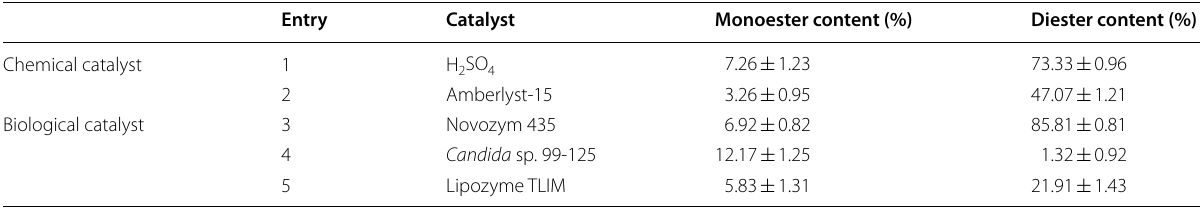
Table 1 Esterification of BDO and LA catalyzed by various